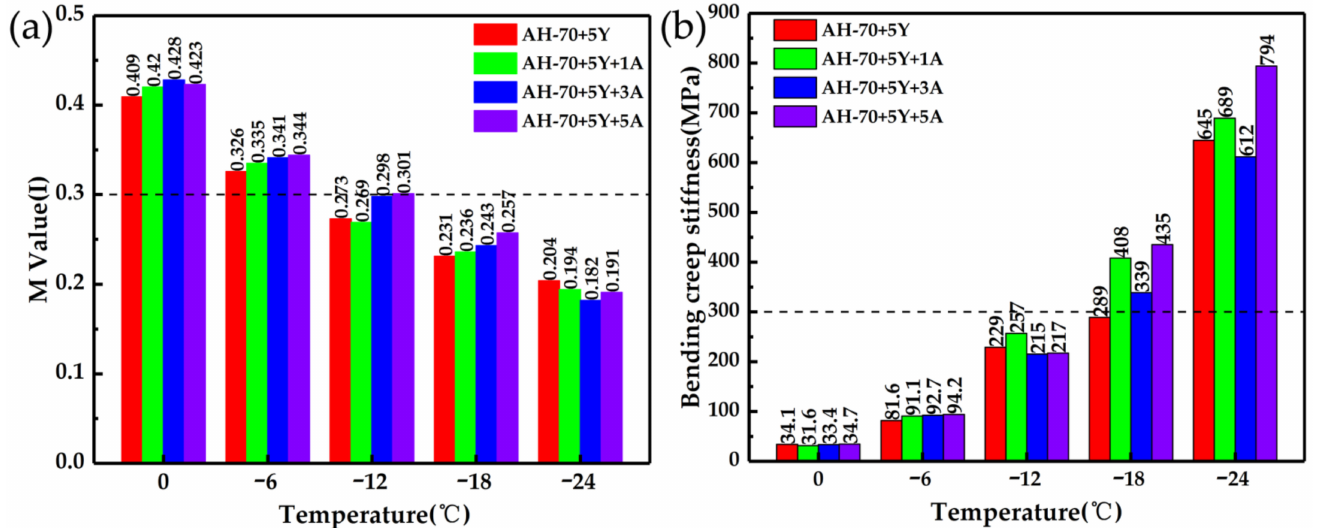
Figure 8. ( a ) M values and ( b ) bending creep stiffness of modified asphalt under different